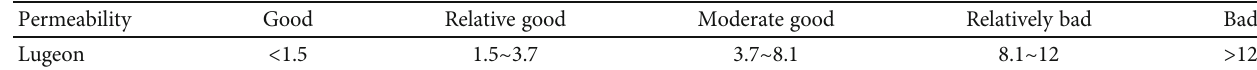
Table 6: Division standard of rock mass